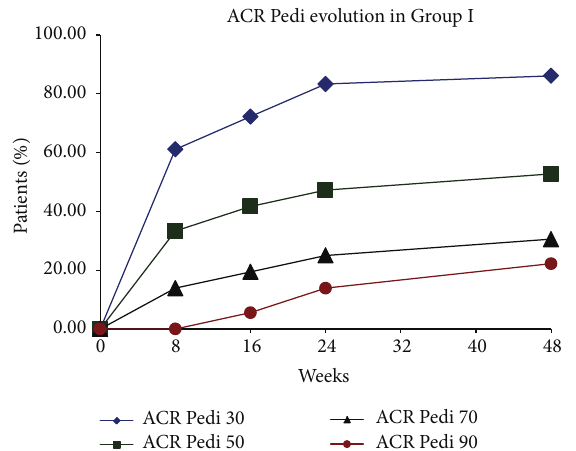
Figure 6: Evolution of ACR Pedi 30/50/70/90 responses in Group